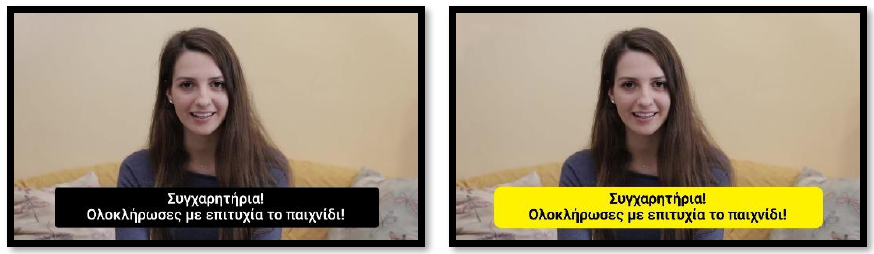
Figure 21. Post-production phase: color subtitles/background. Subtitling while the pedagogical